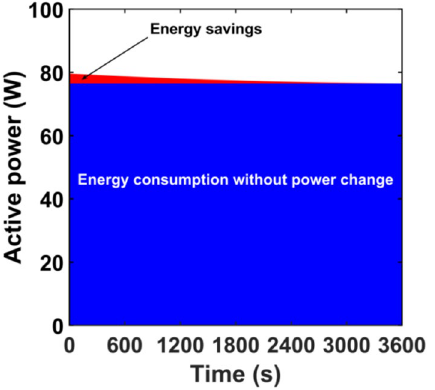
Figure 7. Illustration of how energy savings are calculated.